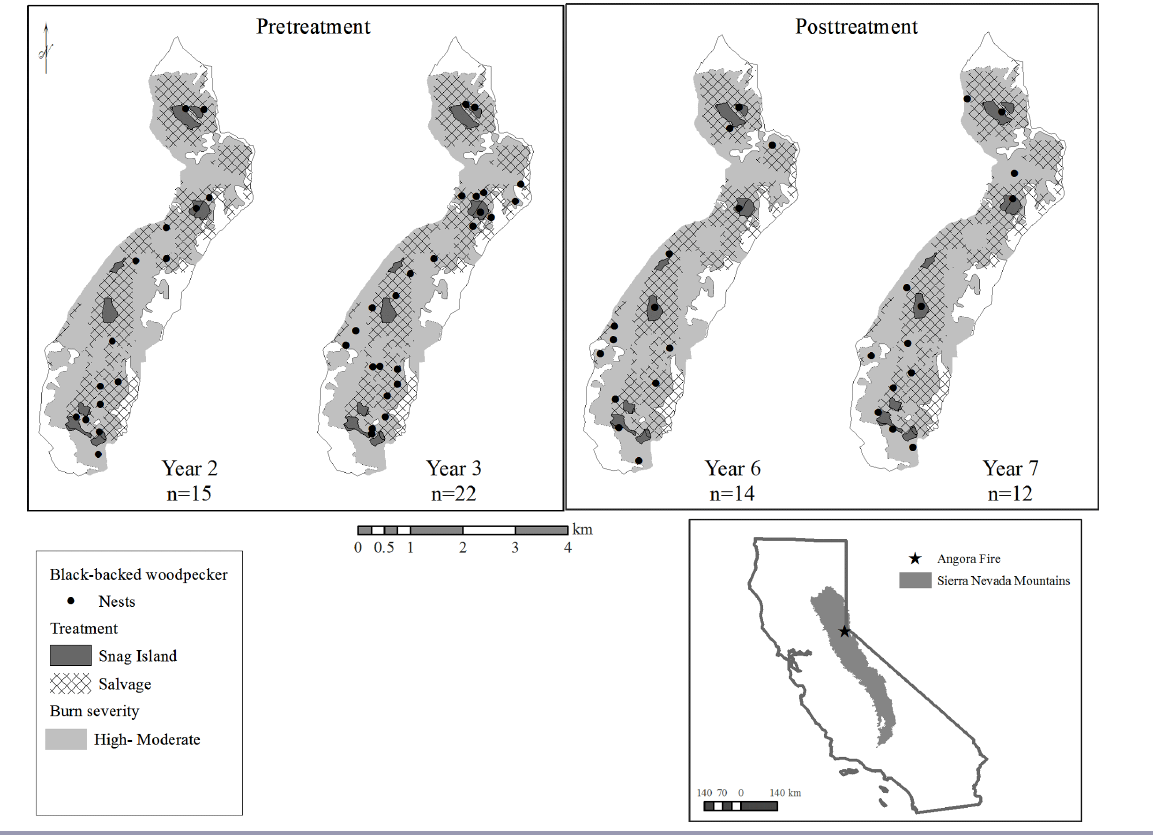
Fig. 1 . Location of Black-backed Woodpecker ( Picoides arcticus ) nests before and after logging in the 2007 Angora fire in the Lake Tahoe basin,